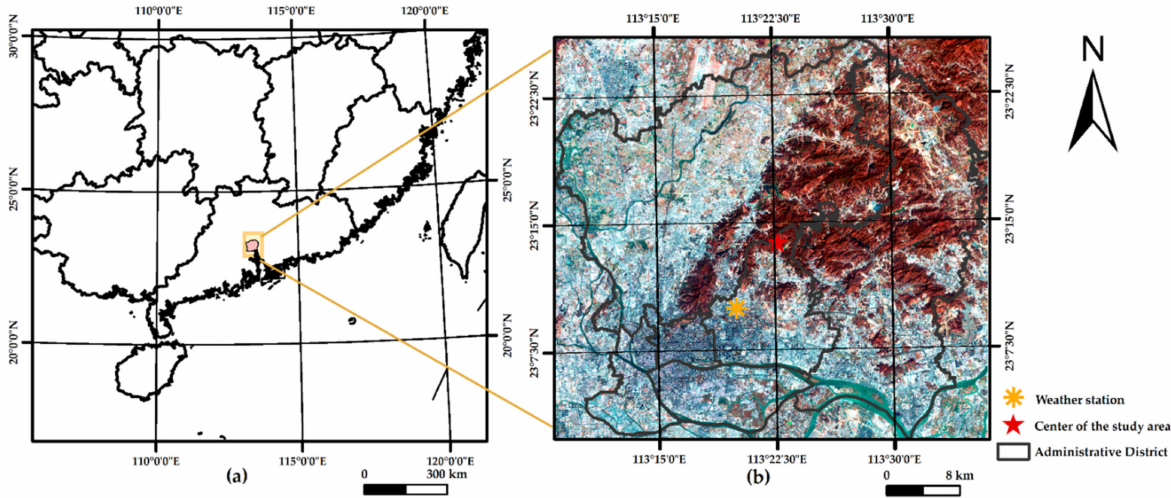
Figure 1. ( a ) Location of the study area in China; ( b ) study area of the Landsat 8 OLI image (2020-02-18) based on the combination of band5, band4,